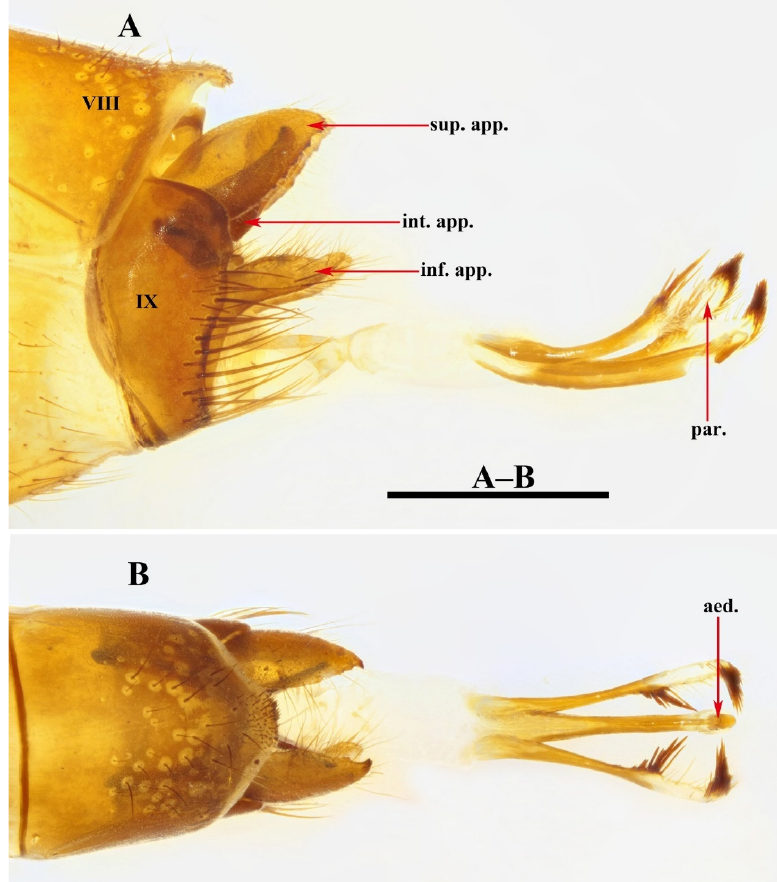
Figure 17 . Limnephilus zhejiangensis , male genitalia. ( A ) Left lateral; ( B ) dorsal. Abbreviations: sup. app. = superior appendages (paired); int. app. = intermediate appendages (paired); inf. app. = inferior appendages (paired); aed. = aedeagus; par. = paramere. Scale bar: 1 mm.